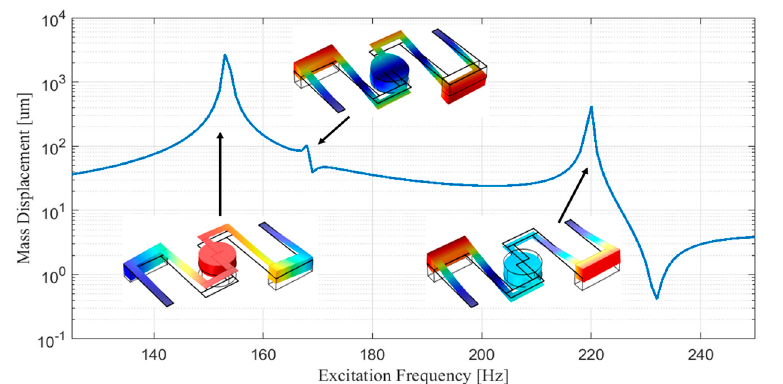
Figure 2. Frequency spectrum and mode shapes of the optimized wideband energy